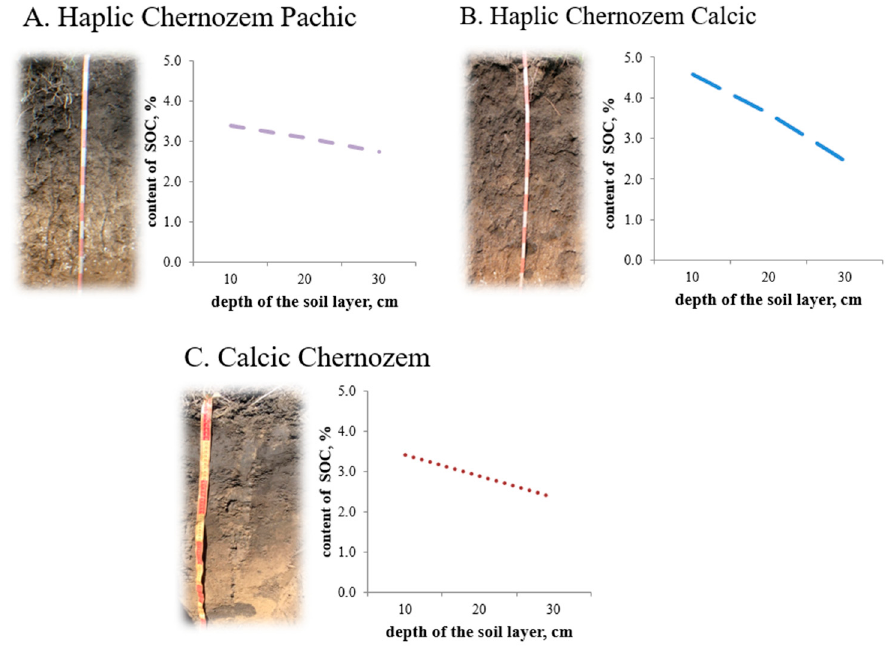
Figure 2. Change in SOC (% content) in VS of different soil types ( A – C